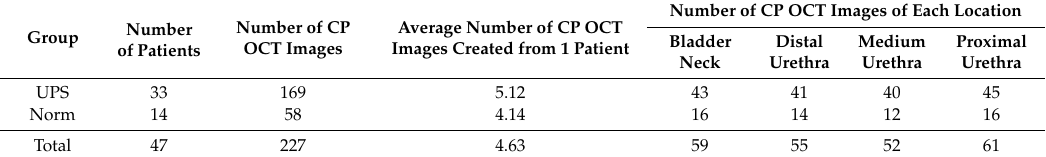
Total 47 Table 2. Distribution of the CP OCT images by patient’s groups and parts of the urethra.